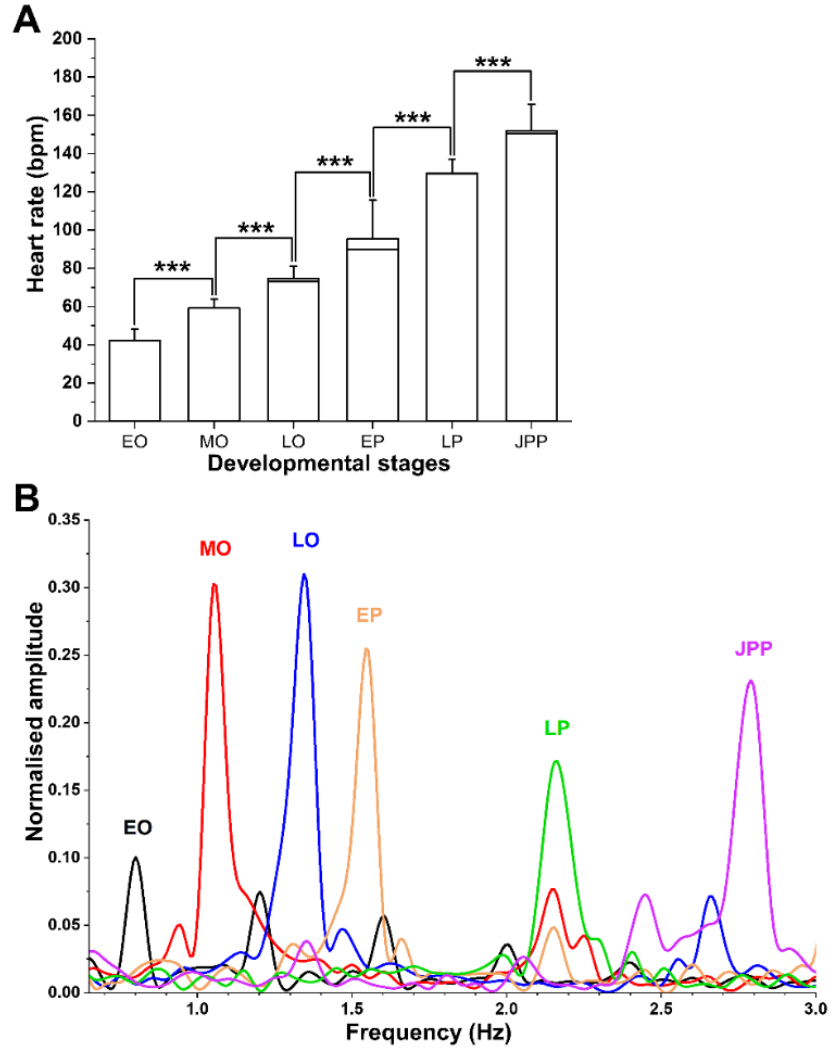
Figure 8. Graphs illustrating increasing heart rates and frequencies in advancing developmental stages of G. holbrooki . ( A ) The heart rate of embryos (n = 50/stage) at each developmental stage (EO, mid-organogenesis (MO), late organogenesis (LO), early pharyngula (EP), late pharyngula (LP), and JPP) showed significantly higher HR compared to the preceding stage. The average beats (mean ± SD) per minute (bpm) is shown (*** p < 0.001). ( B ) The average FFT transformed dominant heart frequency (F D ) for the six different embryonic stages also increased with advancing developmental stages and were consistent with the HR counts.